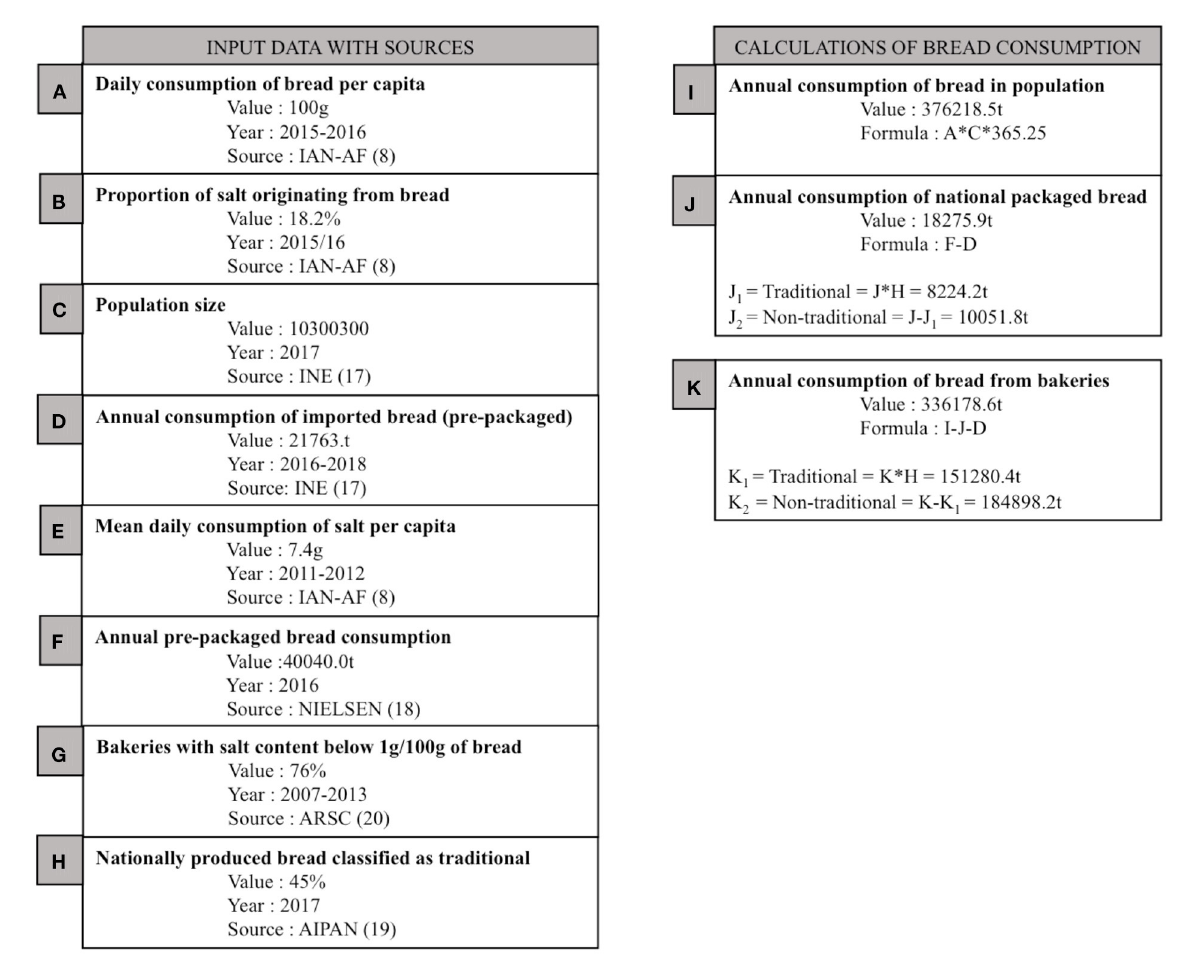
FIGURE1 Data used in this